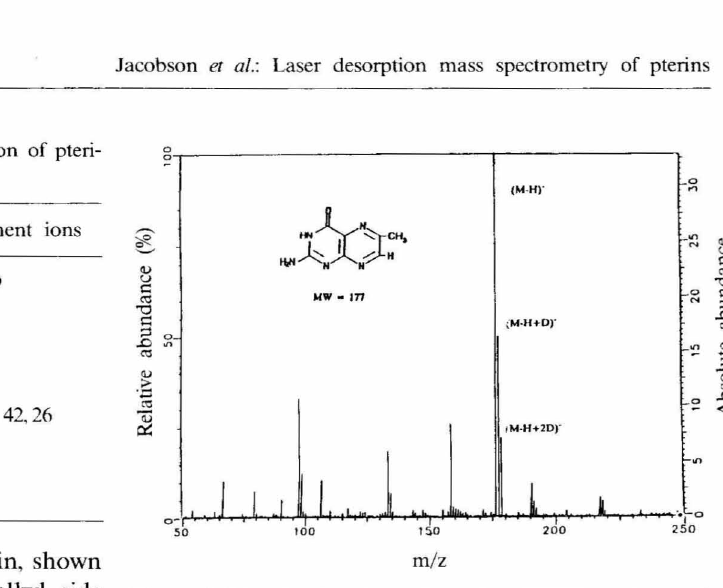
Table 2. Negative ions generated by laser desorption of pteri dines.